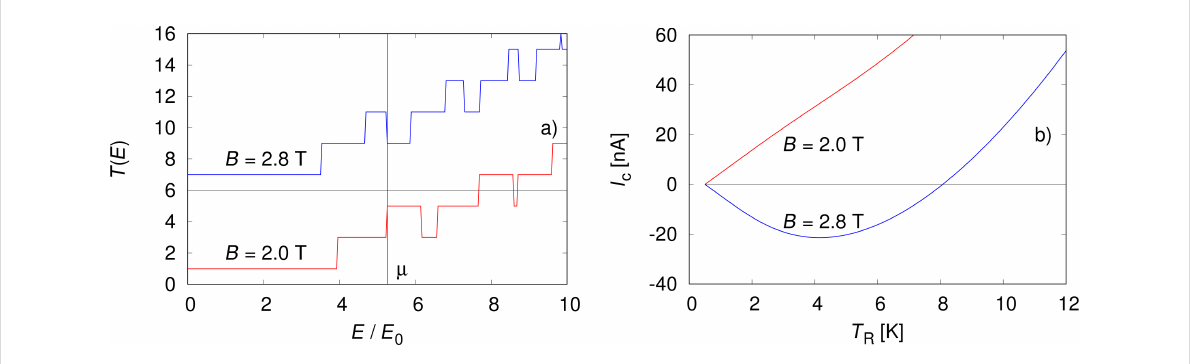
Figure 2: a) Transmission function and b) thermoelectric current for two different magnetic fields. In a), the transmission function T ( E ) for B = 2.8 T is offset by 6 for clarity. We used v F = 10 5 m/s and R = 50 nm for the current calculations, which gives E 0 = ≈ 1.3